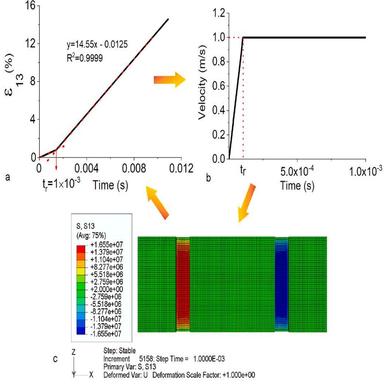
Methodology of optimization in accordance with experiments and FE simulation of double rectangular gauge parts; (a) experimental data, (b) boundary conditions, (c) FE computation optimization of specimen geometry.